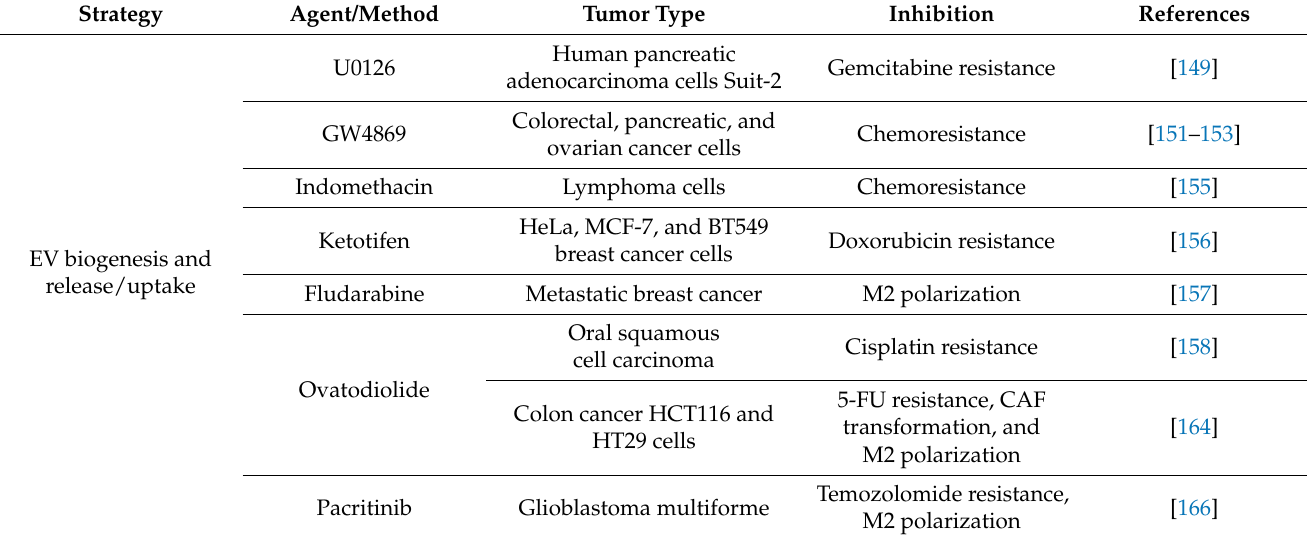
Table 1. EV-based strategies for CSC